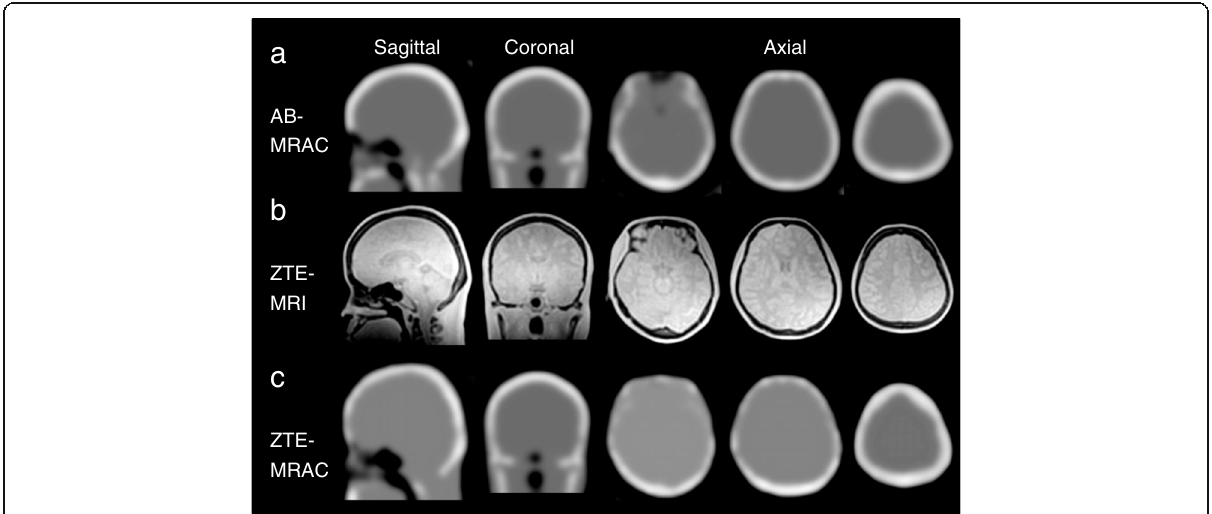
Fig. 2 MRAC maps from the AB- ( a ) and ZTE-based ( c ) methods, and ZTE images ( b ) for PET attenuation correction. Although the ZTE-MRAC shows similar head AC maps to AB-MRAC, there are slight differences in the frontal sinus region (left column of axial sections) and bone thickness in the parietal region (middle and right column of axial sections)